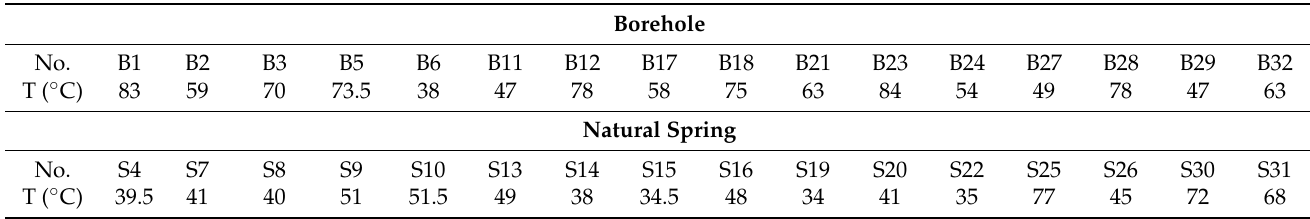
Table 2. Actual measured temperature of thermal mineral